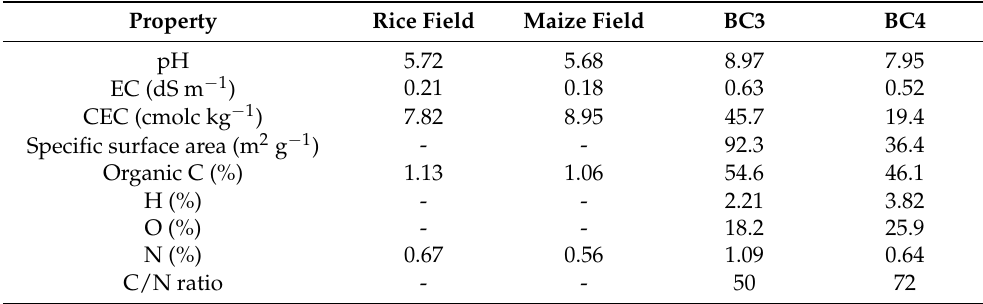
Table 3. Selected properties of soil and